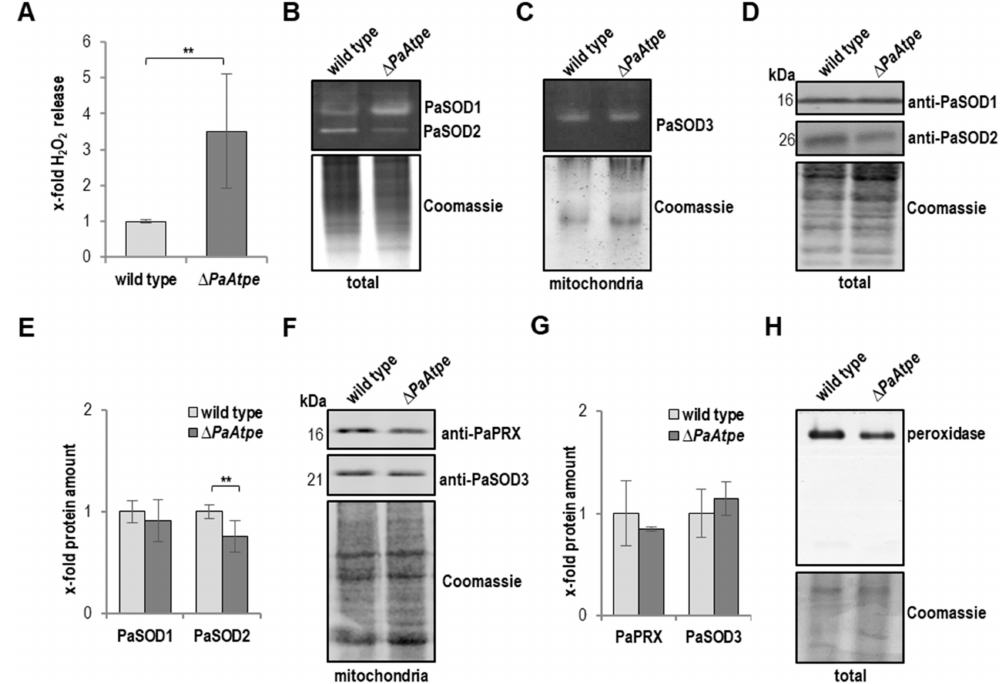
Figure 2. ROS metabolism is affected by the loss of F 1 F o -ATP-synthase dimers. ( A ) Quantitative measurement of hydrogen peroxide (H 2 O 2 ) release from P. anserina wild type ( n = 11) and ∆ PaAtpe ( n = 10). The mean release of hydrogen peroxide of the wild type was set to 1. ( B ) Representative superoxide dismutase (SOD) (PaSOD1 and PaSOD2) activity gel from total protein extracts of P. anserina wild type and ∆ PaAtpe (each 4 biological replicates). ( C ) Representative superoxide dismutase (PaSOD3) activity gel from mitochondrial protein extract of P. anserina wild type and ∆ PaAtpe (each 3 biological replicates). ( D ) Western blot analysis of total protein extract of P. anserina wild type and the ∆ PaAtpe mutant (each 4 biological replicates). ( E ) Quantification of PaSOD1 and PaSOD2 protein abundance normalized to the Coomassie stained gel. Protein level in wild-type cultures was set to 1. ( F ) Western blot analysis of mitochondrial protein extract of P. anserina wild type and ∆ PaAtpe (each 3 biological replicates). ( G ) Quantification of PaPRX and PaSOD3 protein levels normalized to the Coomassie stained gel. Protein level in wild-type cultures was set to 1. ( H ) Representative peroxidase activity gel from total protein extracts of P. anserina wild type and ∆ PaAtpe (each 4 biological replicates). ( A , E , G ) Error bars correspond to the standard deviation and p -value was determined by two-tailed Student’s t -test. ** p <